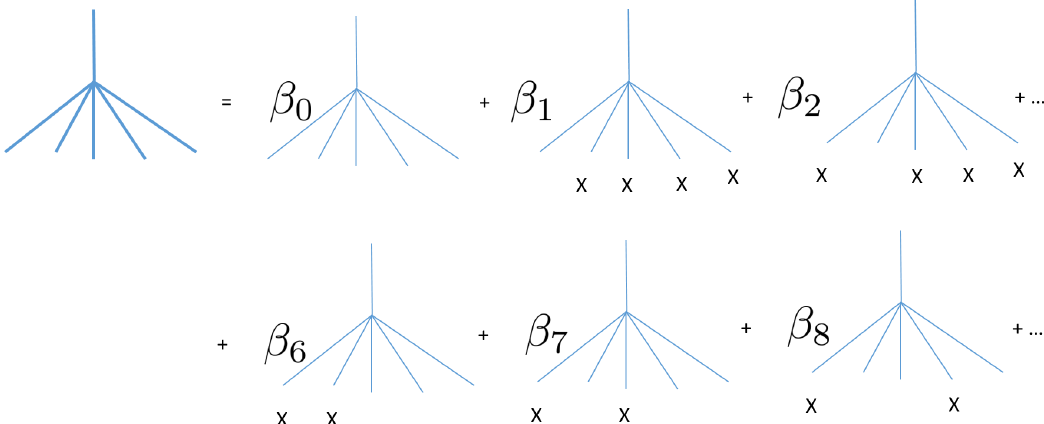
Figure 44. We construct an imperfect tensor by taking a superposition of the following tensors, where tensor without X insertion is the reference perfect tensor. For small errors, β